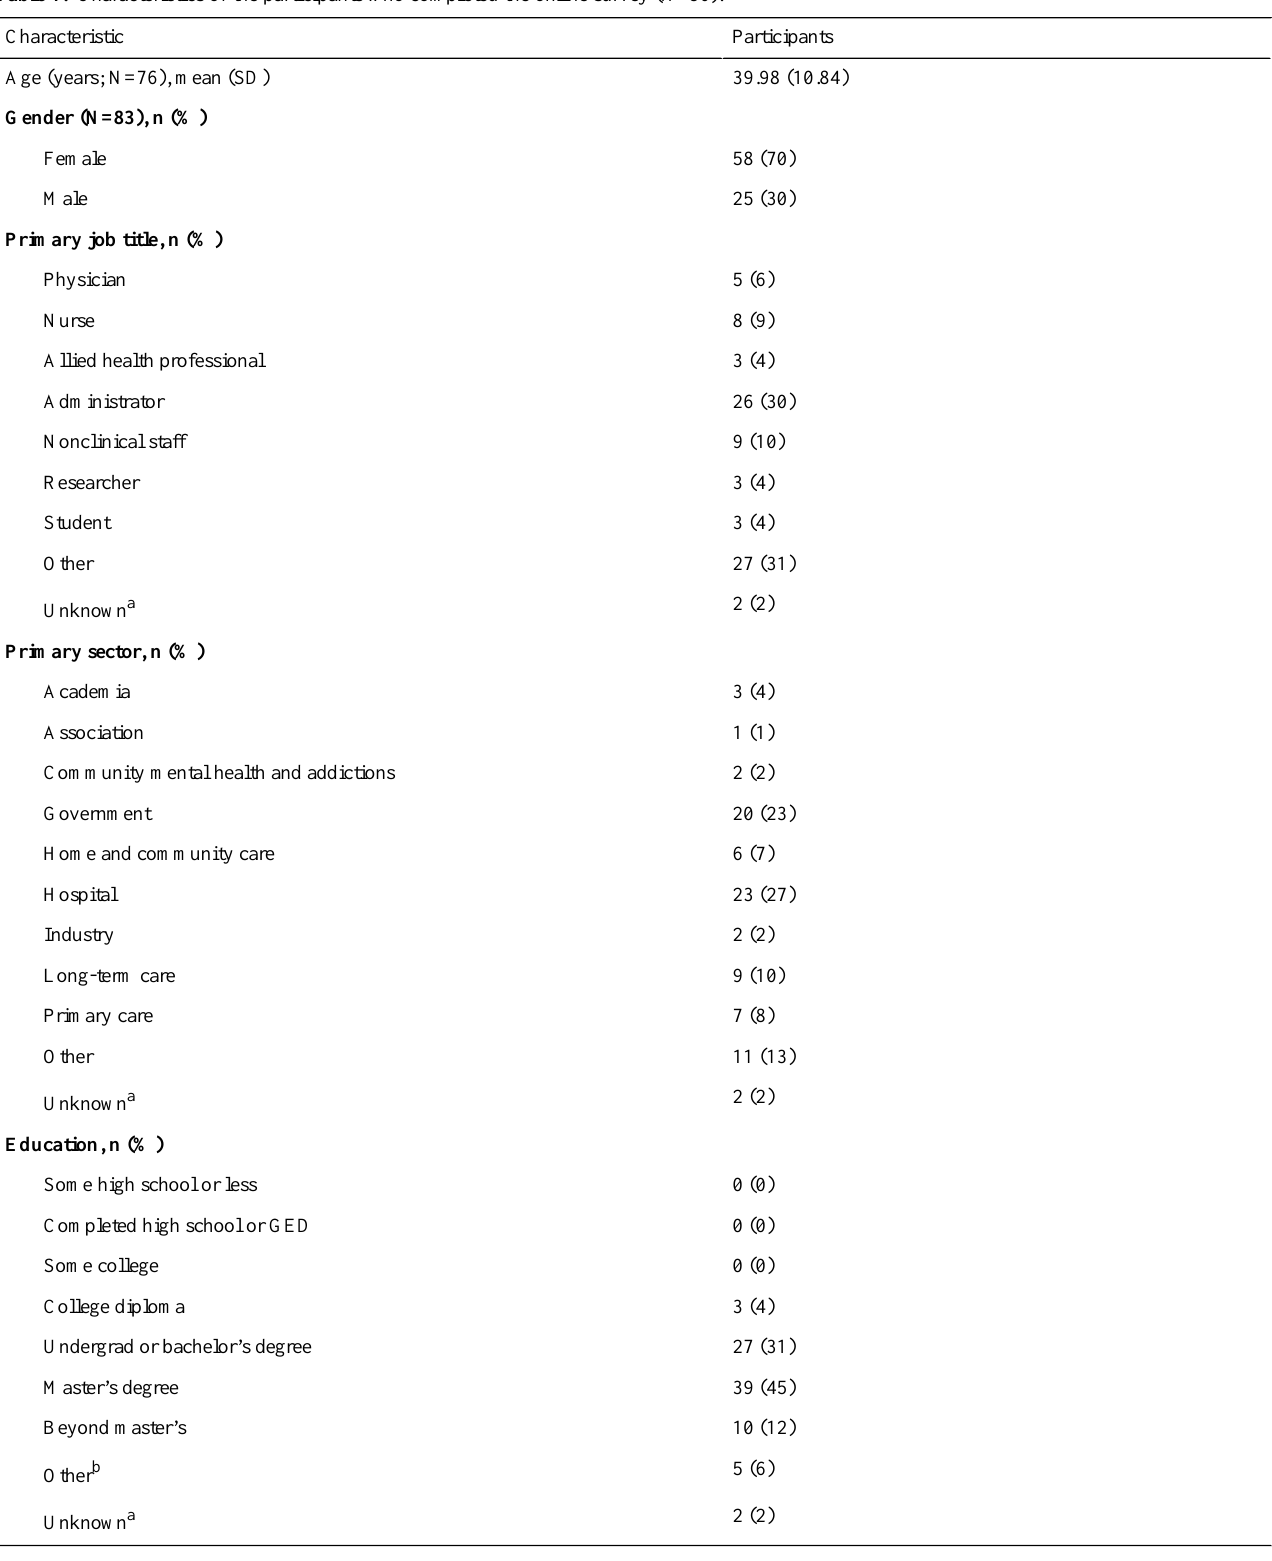
Table 1. Characteristics of the participants who completed the online survey (N=86).